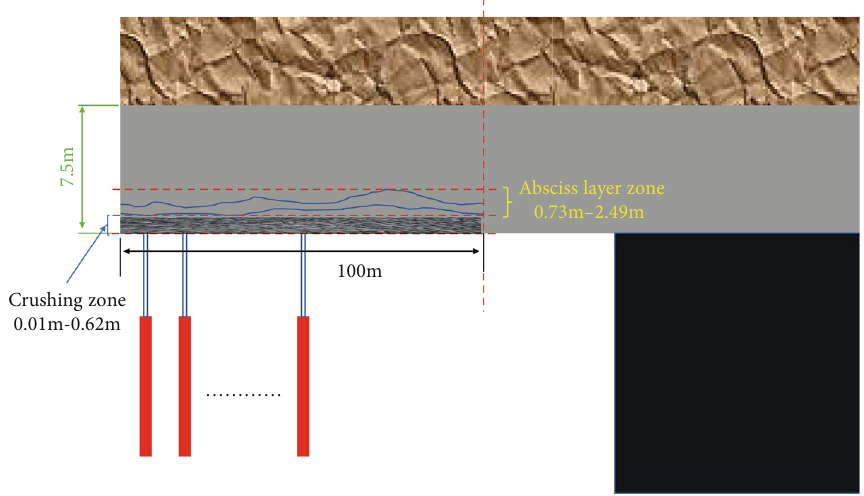
Figure 11: Schematic diagram of distribution range of roof separation development area.